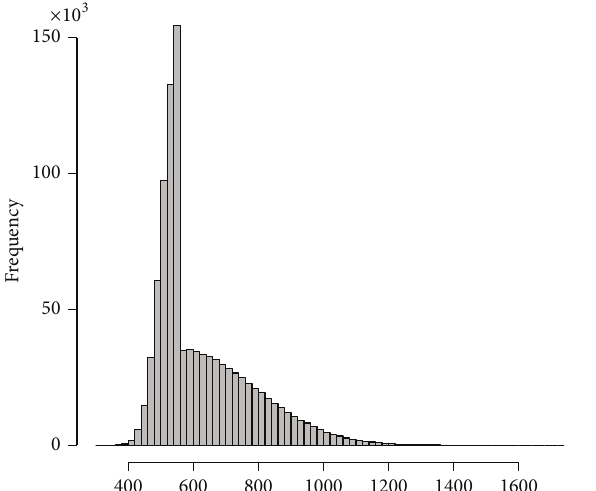
Figure 9: Histogram for a split-normal distribution SN (𝑚 = 559.82, 𝜎 1 = 50,𝜎 2 = 225.68) with 𝜇 = 700 and 𝜎 = 150 (see Table 5).